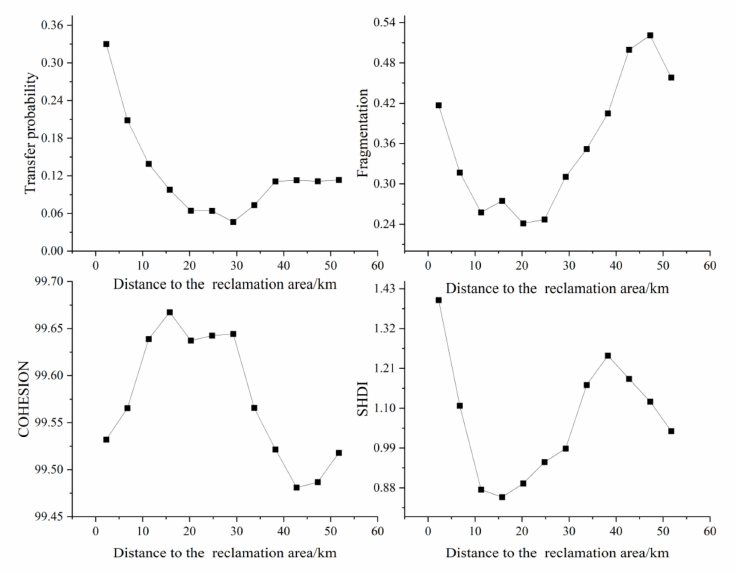
Figure 4. The overall transfer probability and landscape pattern indices in buffer